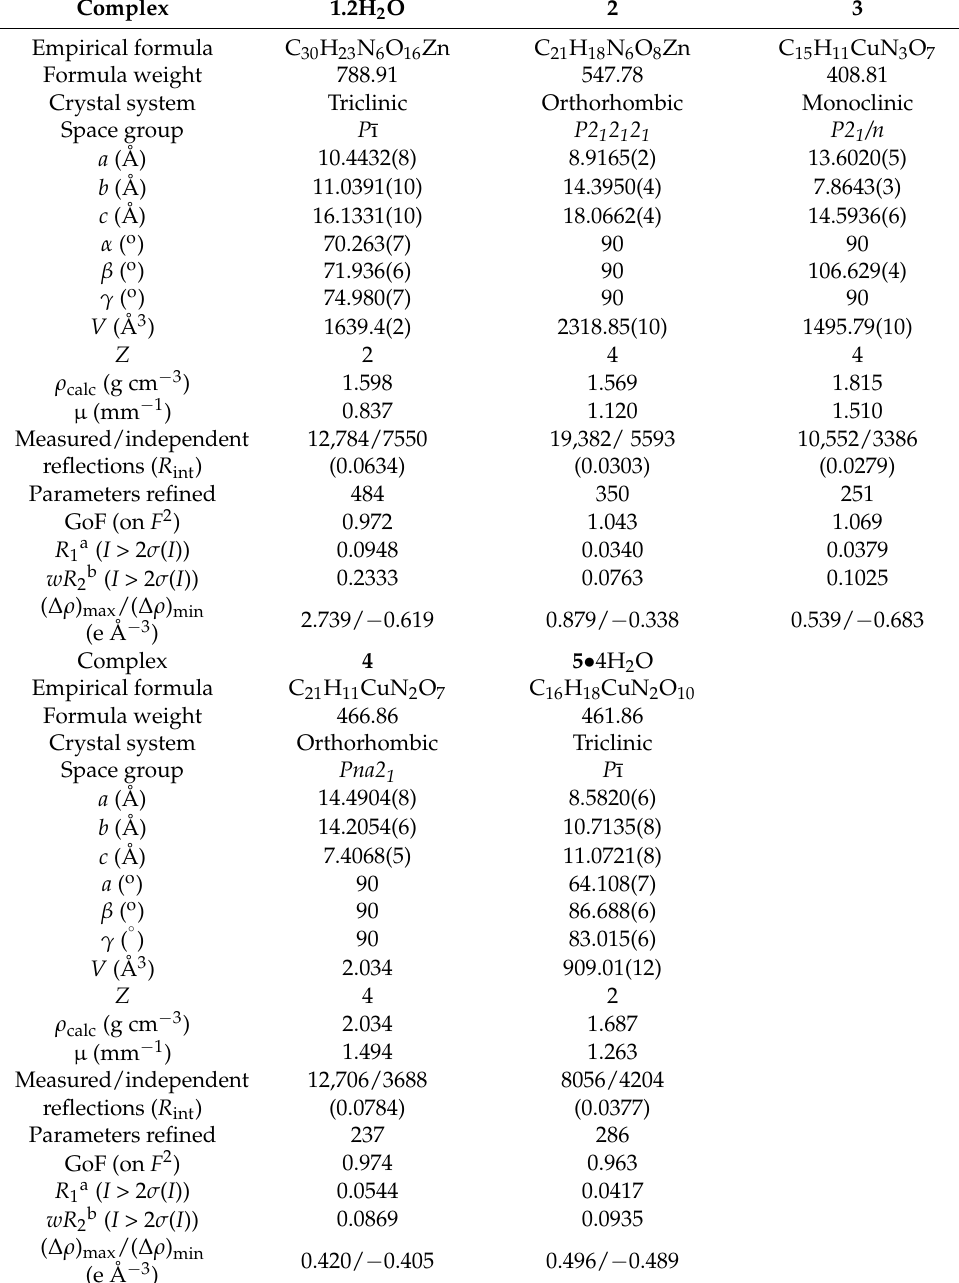
Table 1. Crystallographic data for complexes 1 – 5